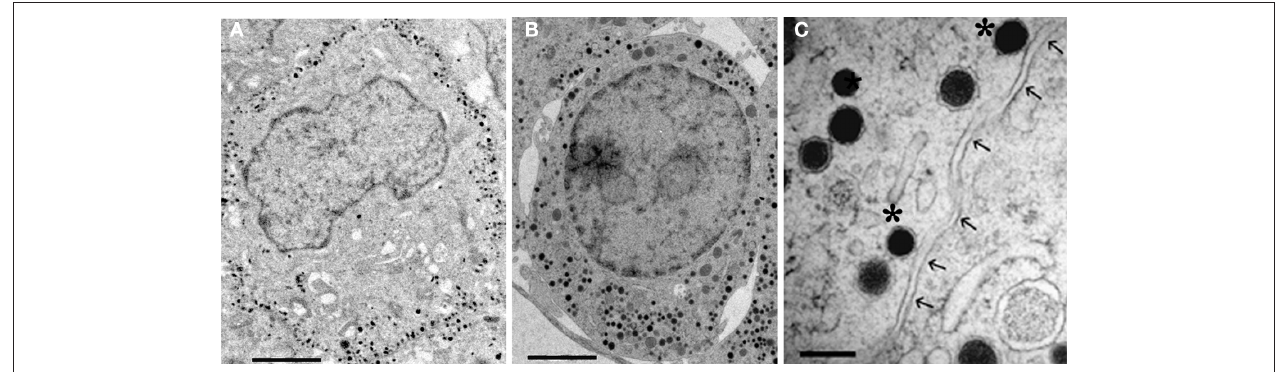
cell after high pressure freezing. Two dense-core vesicles would be classified as docked (*) based on visible contact with the cell membrane (arrows). Scale bar: (A,B) , 2 μm (C) , 250